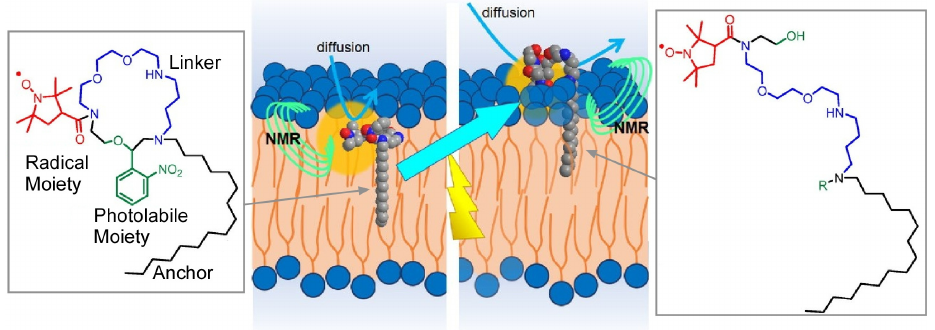
Figure 12. A photodegradable macrocyclic compound to measure water around liposomes in situ that is originally buried in the lipid bilayer and then brought out by the photocleavage reaction. Reprinted with permission from Reference [152]. Copyright 2022 Chemical Society of Japan.